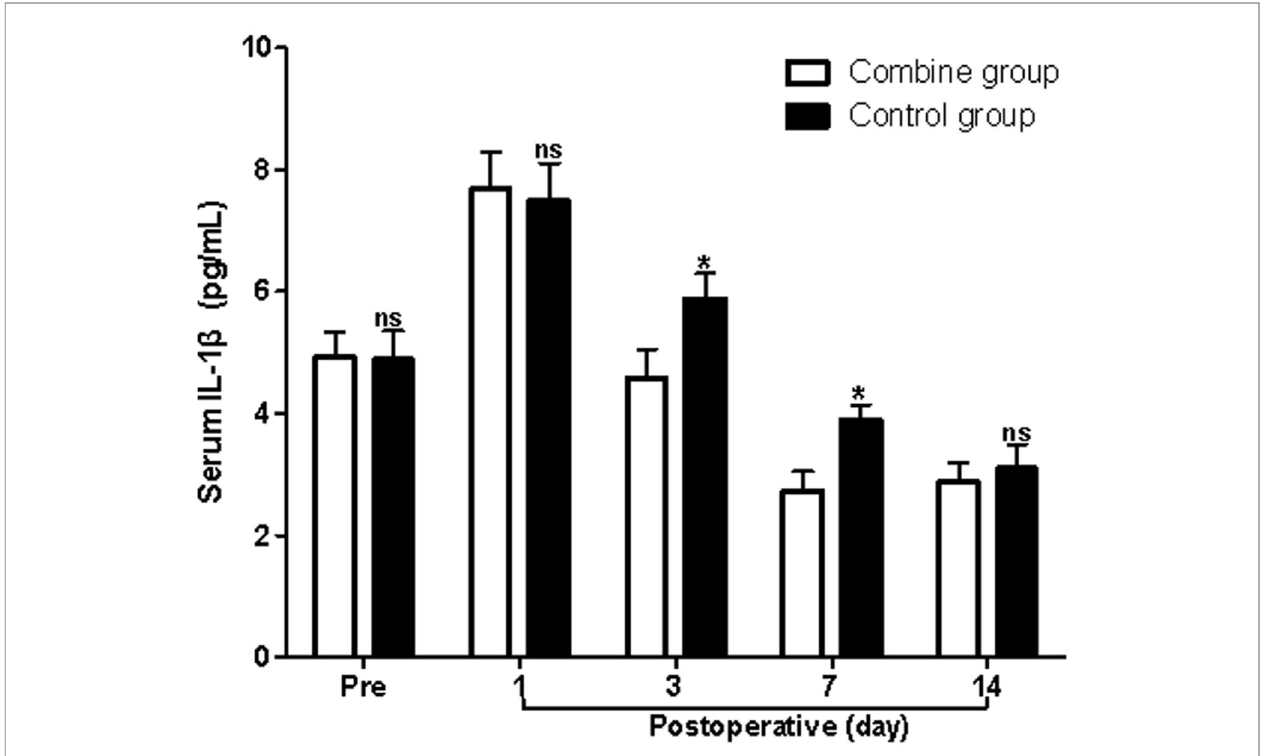
FIGURE 4 | Comparison of serum IL-1 β levels at different times in patients of two groups. Note: Compared with the combine group, ns p >0.05 and * p <0.05.